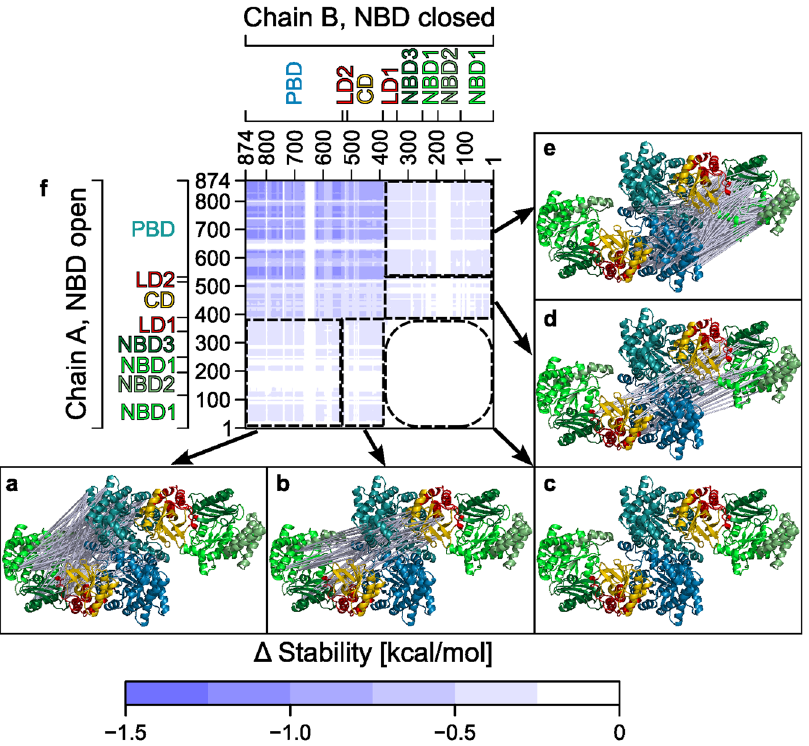
Figure 4. Effect of the dimerization on the stability of PPDK as computed by CNA. Difference in the stability of rigid contacts between two residues projected onto C α atoms of the PPDK structure 5JVJ (missing atoms were added by homology modeling) and color-coded according to the scale at the bottom: Between ( a ) NBD and PBD, ( b ) NBD and CD, (c) NBD and NBD, ( d ) CD and NBD, and (e) PBD and NBD of chain A and chain B, respectively. ( f ) Stability map of the intermolecular differences in rigid contacts. Rigid contacts that are more stable in the dimer than in the monomer are indicated in darker blue colors. The residue numbering is given on the left and on the bottom, as are labels for the domains. For clarity rigid contacts between only every 20 th residue are displayed in panels ( a ) to ( e ). See Supplementary Fig. S7 for a display of all rigid